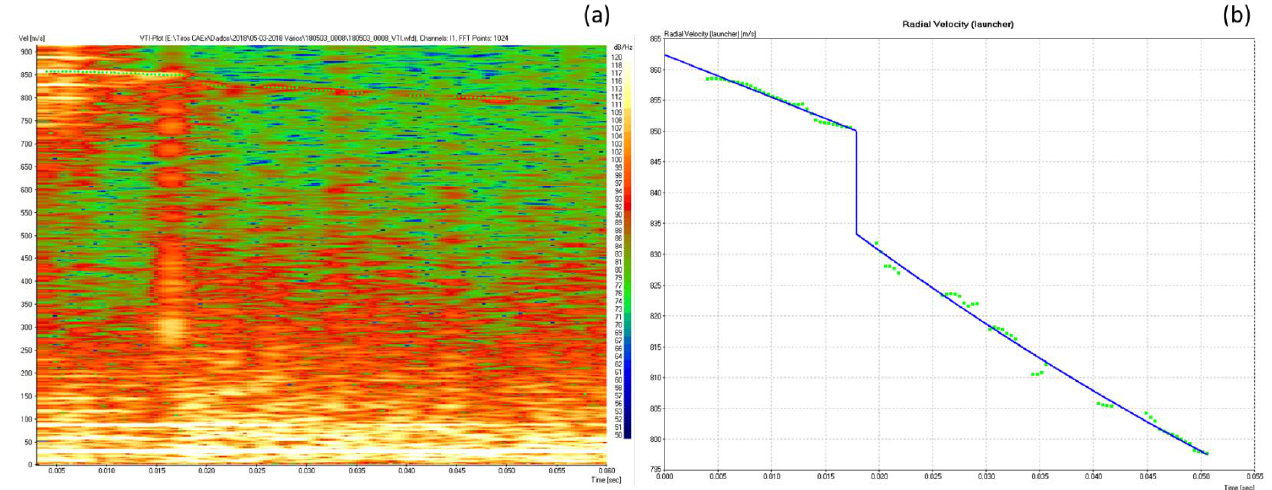
Figure 2. Doppler radar results ( a ) raw and ( b ) processed data.